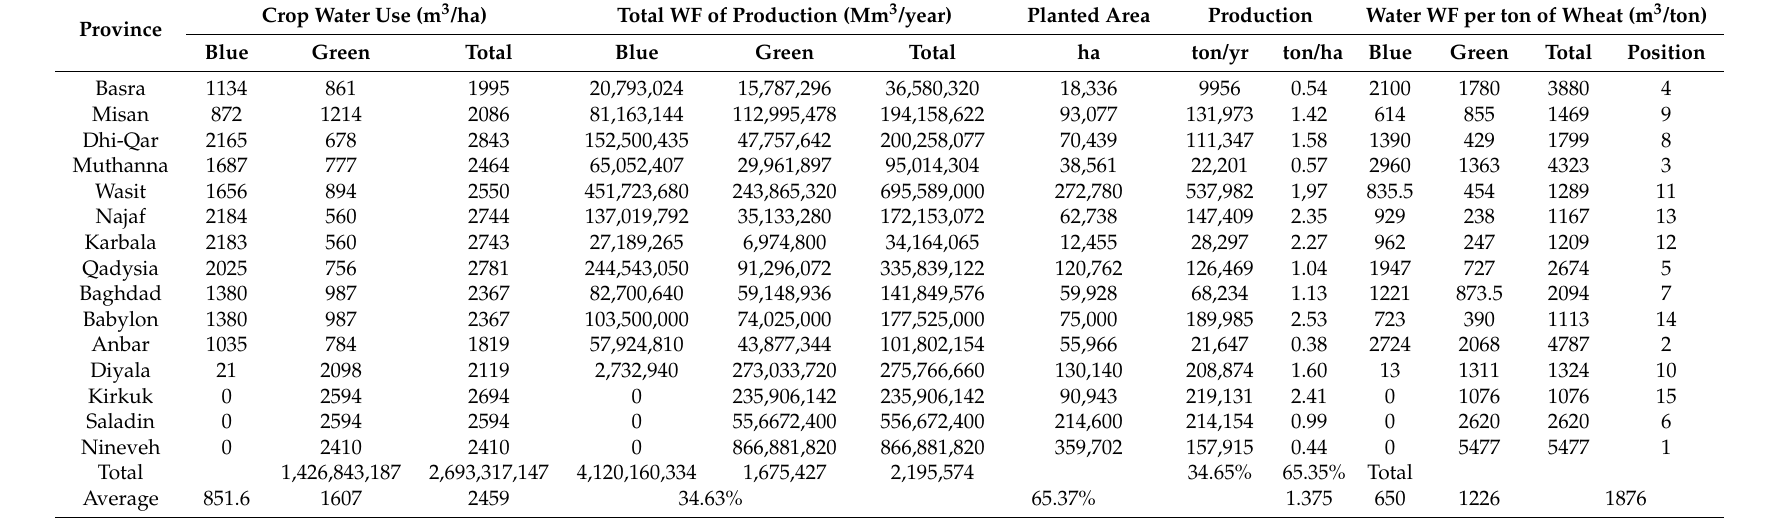
Table 3. Calculated wheat WF in Iraqi provinces during